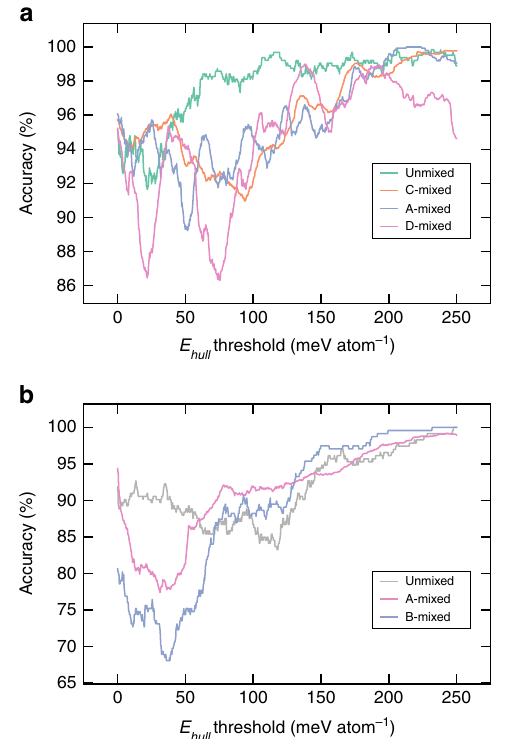
Fig. 4 Accuracy of stability classi fi cation. Plots of the accuracy of stability classi fi cation of the ANN models compared to DFT as a function of the E hull threshold for a . garnets, and b . perovskites. The accuracy is de fi ned as the sum of the true positive and true negative classi fi cation rates. A true positive (negative) means that the E hull for a particular composition predicted from the optimized arti fi cial neural network model and DFT are both below (above) the threshold. For the mixed compositions, an E hull is calculated for all orderings (20, 7, and 18 orderings per composition for C-, A-, and D-mixed garnets, respectively, and ten orderings per composition for both A- and B-mixed